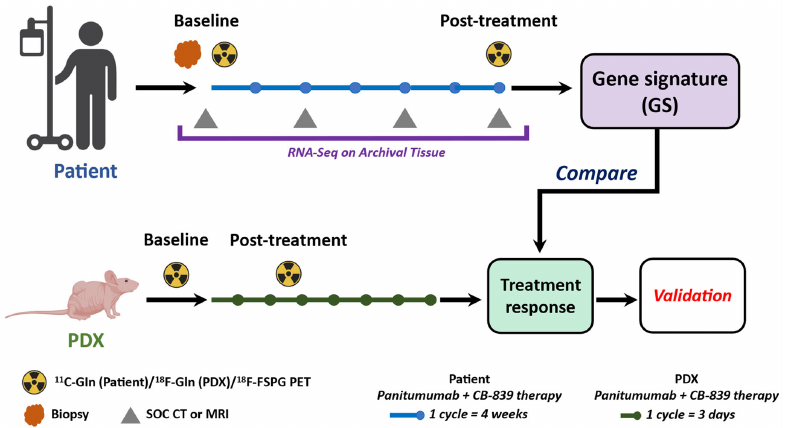
Figure 3. Scheme of the co-clinical trial. Patients with WT KRAS CRC and immunocompromised nude mice bearing WT KRAS CRC PDX tissues receive the therapy with combined panitumumab and CB-839. Tumors are imaged pre- and post-treatment with 11 C-glutamine/ 18 F-glutamine and 18 F-FSPG. Complementary to genomic approaches, a PET imaging-derived gene signature associated with treatment response is established.